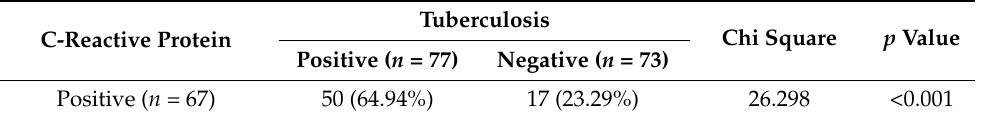
Table 5. Comparison of CRP positivity and TB.